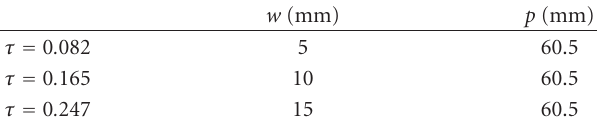
Table 1: Di ff erent values of w and p